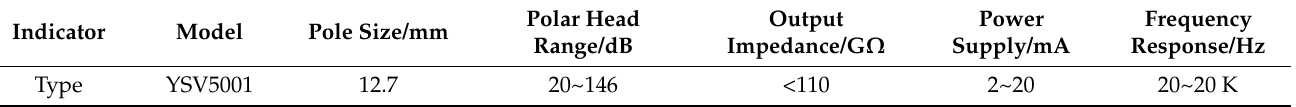
Table 3. Related technical indexes of the sound pressure sensor.